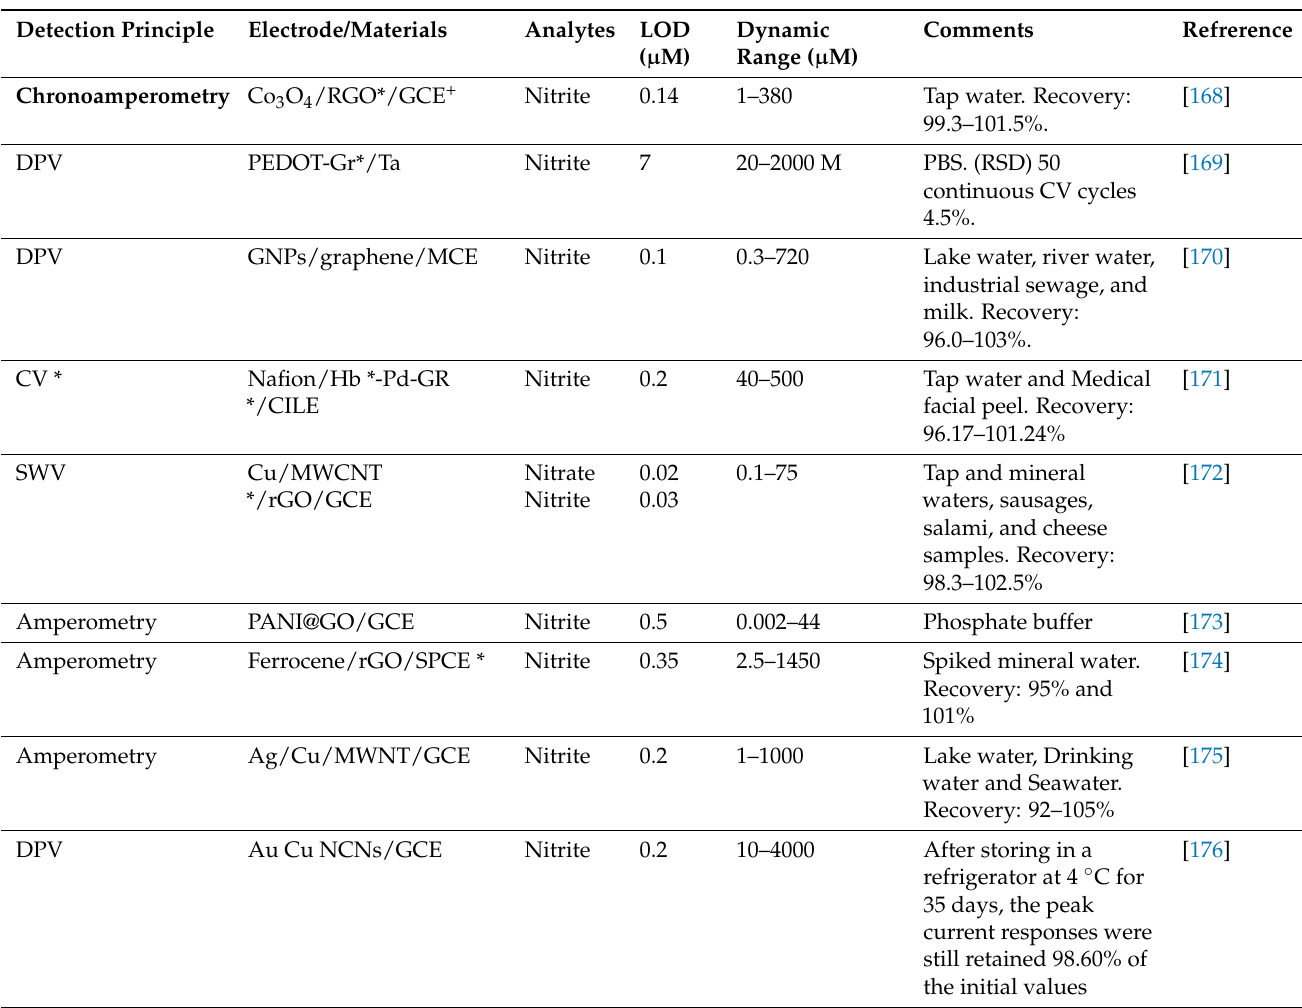
Table 5. Sensor for nitrogen ions (NO 3 , NO 2